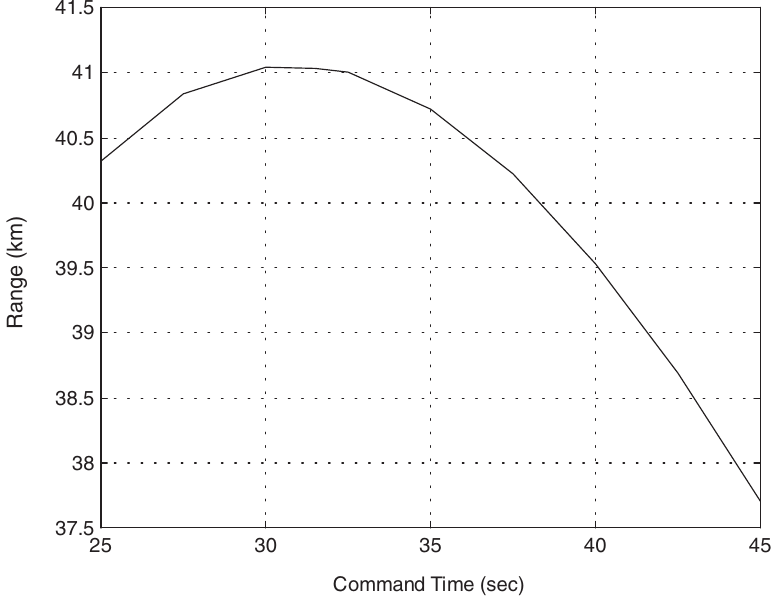
Fig. 15. Range vs. canard command activation